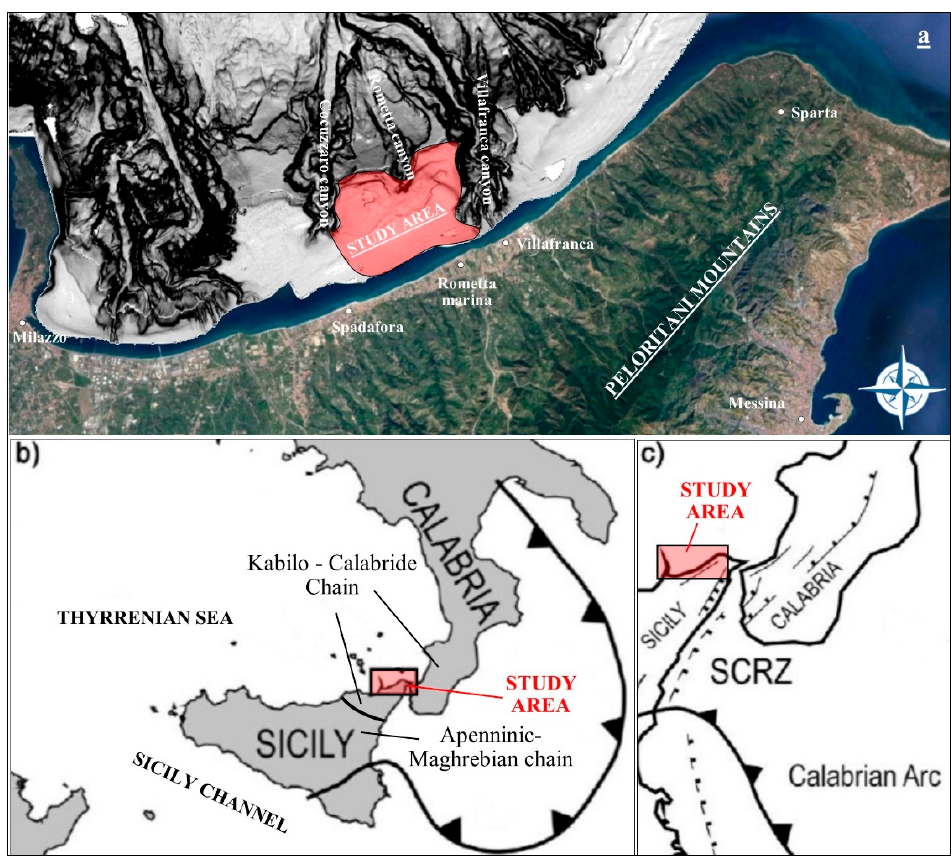
Figure 1. ( a ) Geographic map (WGS84) of north-eastern Sicily and the offshore sector (red area) investigated in the present study through a bathymetric survey (multibeam data). ( b ) Regional location of the study area; the black arrows show the extensional regime responsible for the Siculo- Calabrian Rift Zone above the Calabrian Arc subduction zone. ( c ) Schematic reconstruction of the Siculo-Calabrian Rift Zone (SCRZ) in north-east Sicily and in Calabria.